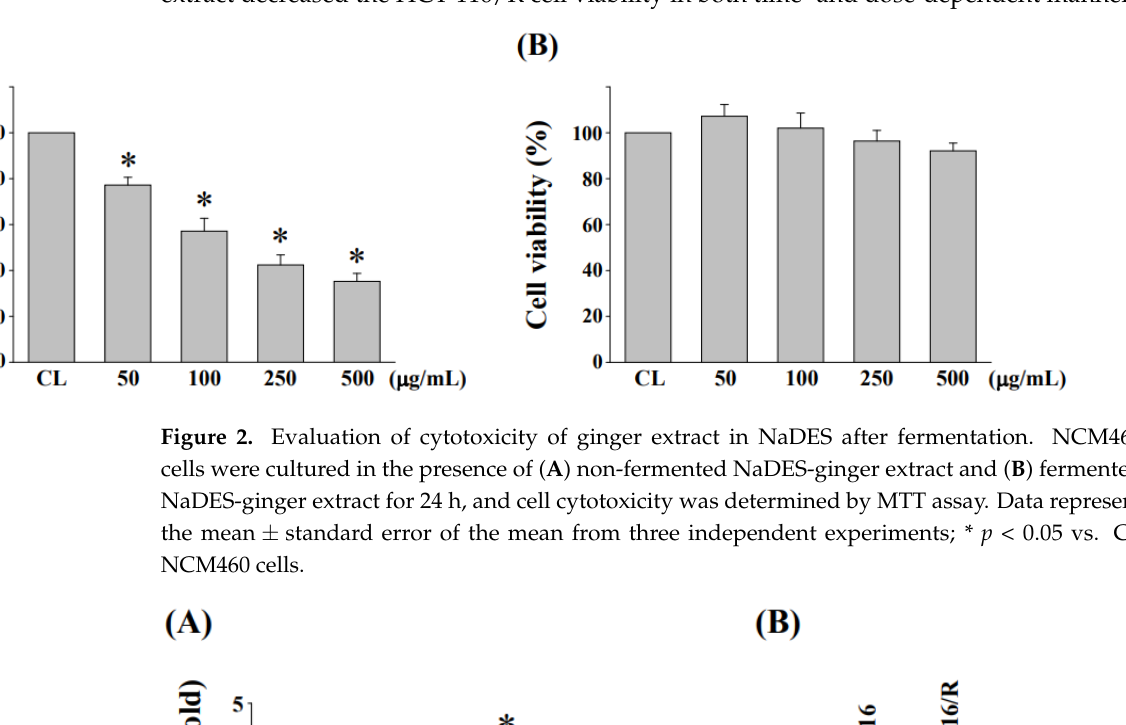
Figure 2. Evaluation of cytotoxicity of ginger extract in NaDES after fermentation. NCM460 cells were cultured in the presence of ( A ) non-fermented NaDES-ginger extract and ( B ) fermented NaDES-ginger extract for 24 h, and cell cytotoxicity was determined by MTT assay. Data represent the mean ± standard error of the mean from three independent experiments; * p < 0.05 vs. CL NCM460 cells.